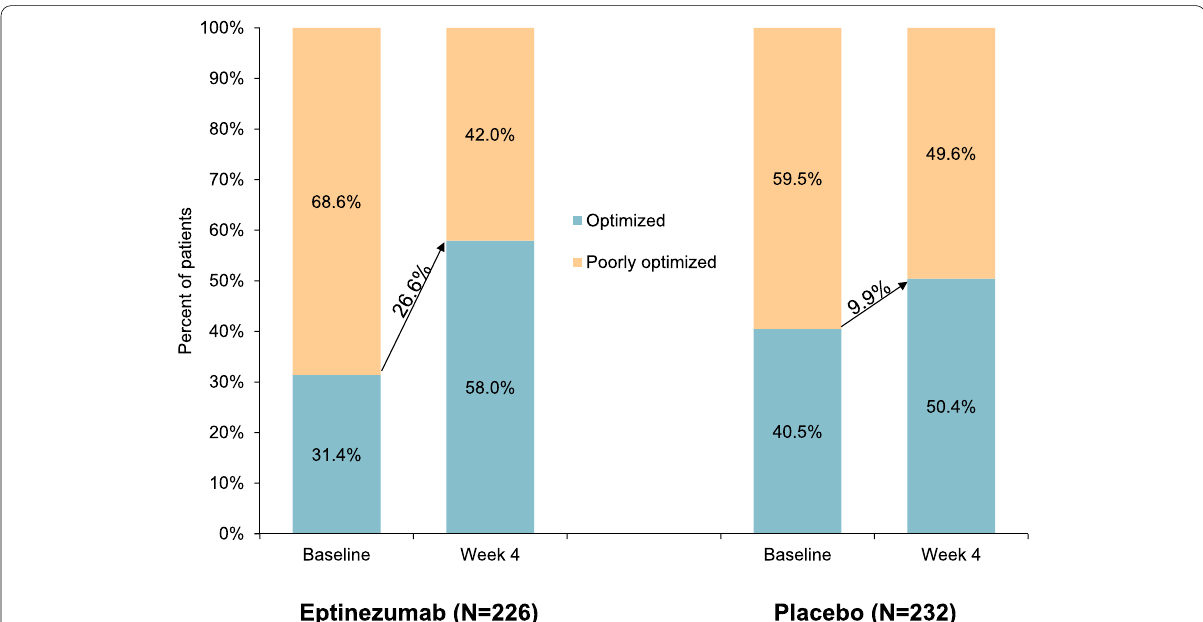
Fig. 2 Simplified distribution of acute medication optimization (mTOQ-4) at baseline and week 4. The mTOQ-4 was derived from the mTOQ-6 by selecting the items that best assessed efficacy: “2-h pain free,” “24-h relief,” “able to plan,” and “in control.” Each item is rated never (1), rarely (2), less than half the time (3), or half the time or more (4). Poorly optimized comprises the “very poor” and “poor” categories; optimized comprises “moderate” and “maximal.” Simplified subgroups consist of patients with mTOQ-4 total scores in very poor (0) and poor (1–5) categories together, along with patients with total scores in the moderate (6–7) and maximal (8) categories grouped together. mTOQ-4/mTOQ-6,